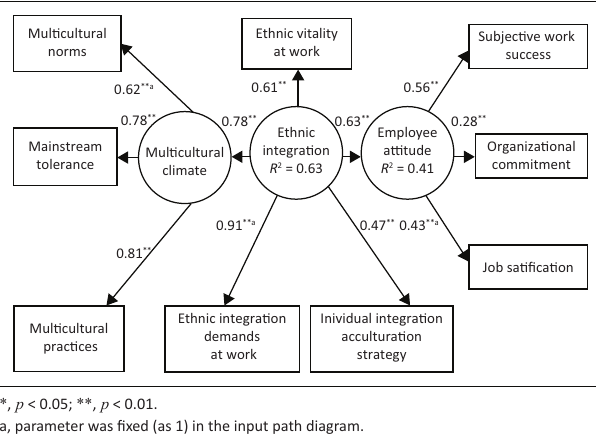
FIGURE 1: A model for multiculturalism at work. TABLE 3: Results of the multi-group structural equation model analysis. Model